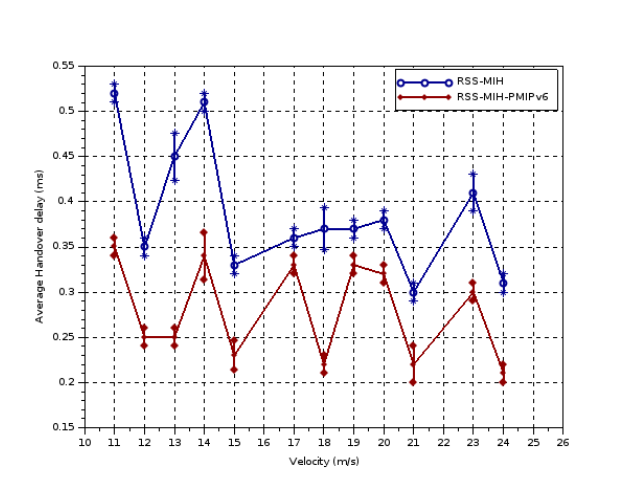
Figure 9. Handover delay according to velocity. The confidence interval is